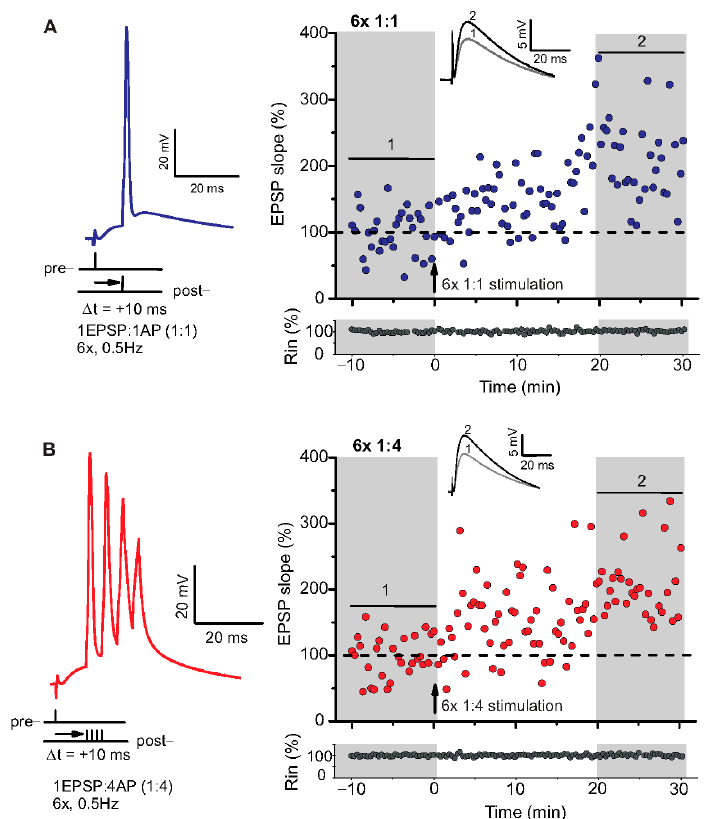
Figure 1. Spike timing-dependent LTP (t-LTP) can be induced with distinct low repeat spike timing- dependent plasticity (STDP) paradigms in 6-month-old adult mice. Whole cell patch clamp recordings (in current clamp) of timing-dependent LTP at SC-CA1 synapses of hippocampal slices from wild type mice. ( A ) One presynaptic EPSP paired with 1 postsynaptic action potential (AP, 6 × 1:1, left inset) STDP paradigm used to induce canonical t-LTP. Typical recording from an individual cell for 6 × 1:1 stimulation (indicated by arrow) induced t-LTP at SC-CA1 synapses. ( B ) One presynaptic EPSP paired with 4 postsynaptic APs (6 × 1:4 protocol, left inset) STDP paradigm used to induce burst t-LTP. Typical recording from an individual cell for 6 × 1:4 stimulation (indicated by arrow) induced t-LTP at the hippocampal SC-CA1 synapses. Insets: average EPSP before (1) and after t-LTP induction (2). Scale bars are shown in the respective